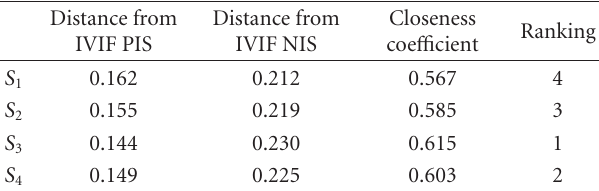
Table 15: Distance of each alternative from IVIF PIS and IVIF